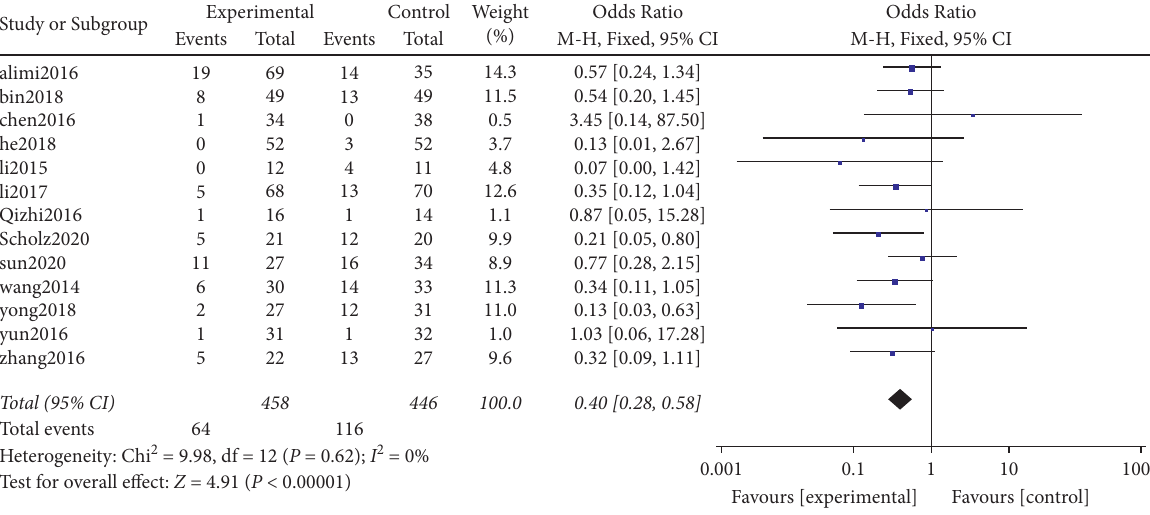
Figure 8: Postoperative dysphagia.